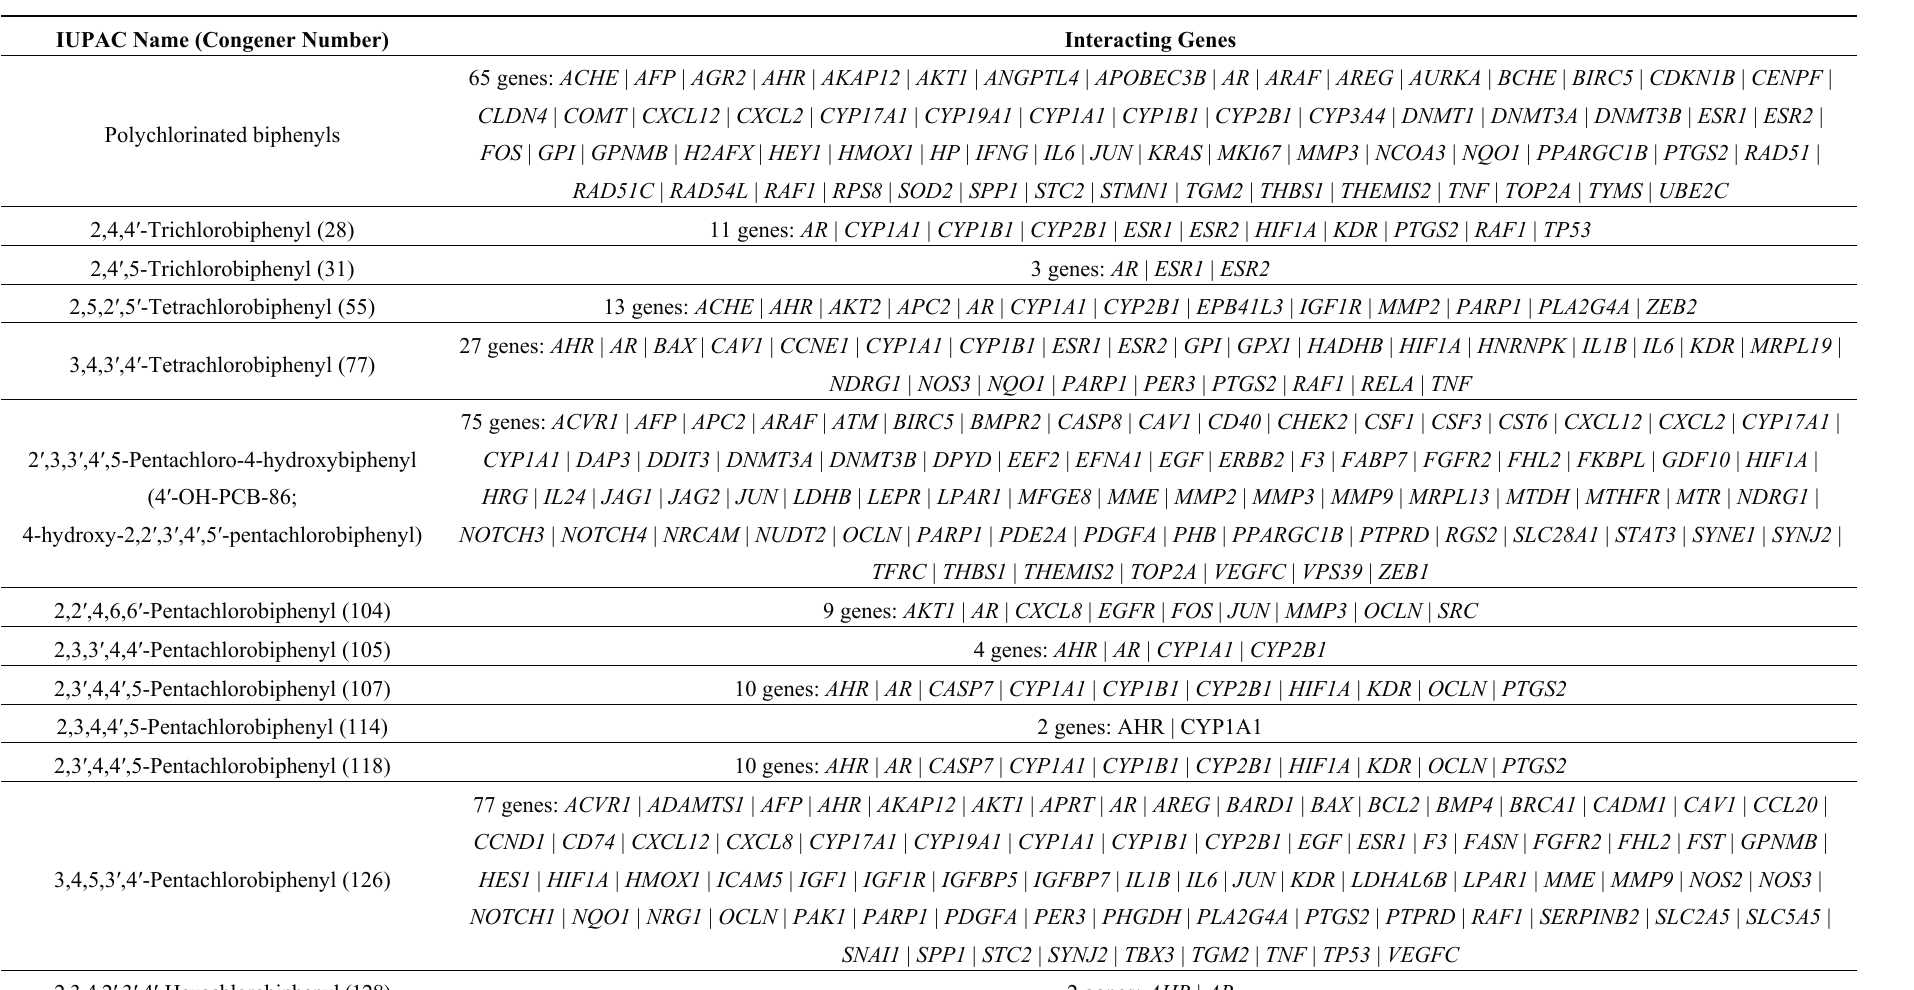
Table 2. Genes interacting with polychlorinated biphenyls in breast